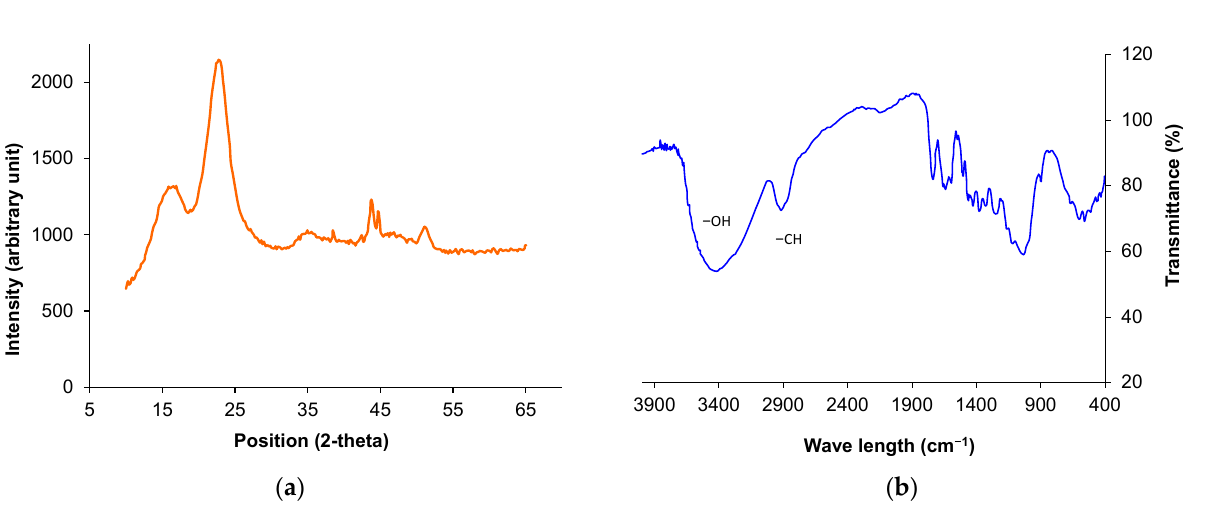
Figure 4. Microstructural characteristics of jute: ( a ) X-Ray diffraction and ( b ) FTIR spectra [28].